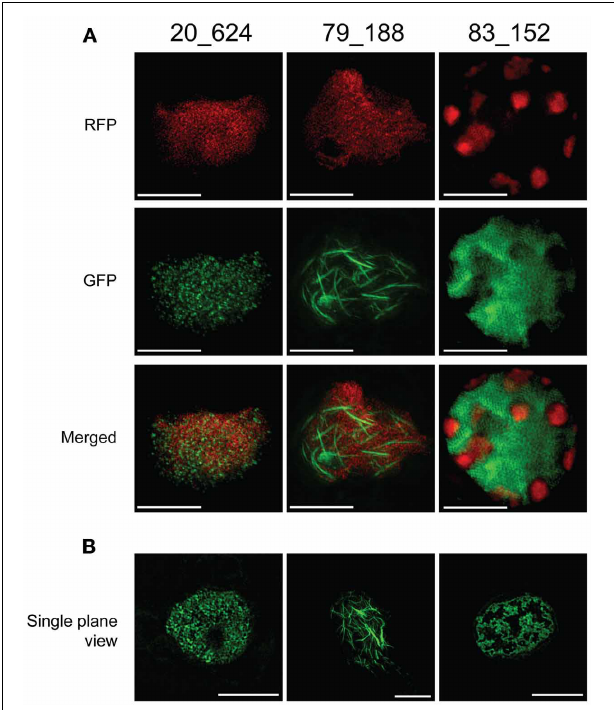
FIGURE 6 | 3D-SIM imagining of CRN C-terminal constructs on OMX confirms distinct localization within the nucleus. (A) Projection view of 3D-SIM images on epidermal peels of N. benthamiana H2B-RFP transgenic lines infiltrated with CRN-GFP fusion constructs. Histone 2B distribution is shown in RFP channel whereas CRN protein distribution is in the GFP channel. Merged channel confirms impairment of chromatin distribution in CRN83_152 expressing cells. (B) Single plane views of 3D-SIM images on epidermal peels of N. tabacum infiltrated with CRN-GFP fusion constructs show distinct nuclear distribution patterns for CRN effector proteins. All images were taken 48h after infiltration. Scale bars = 5 μ